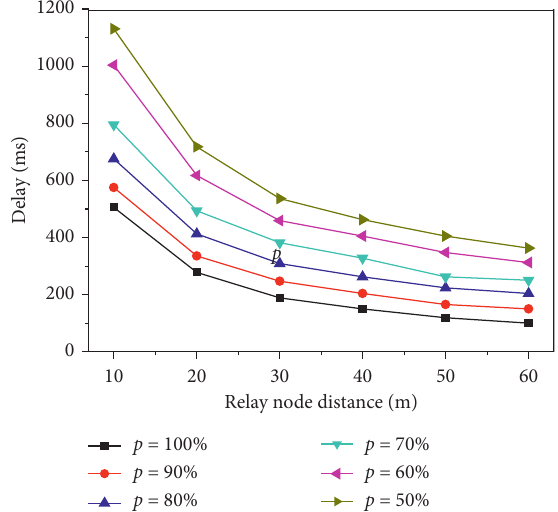
Figure 13: The transmission delay results under different suc- cessful transmission probability p when λ � 0.001.